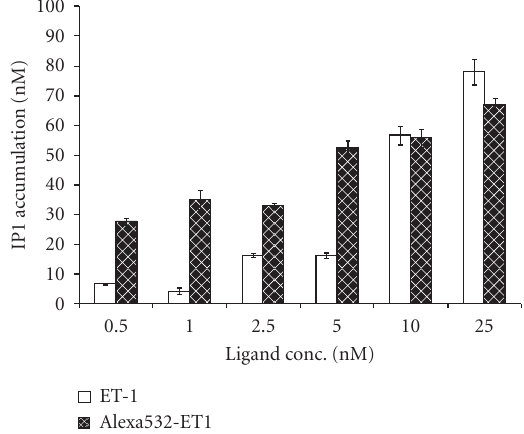
Figure 4: Results of the inositol phosphate (IP1) production assay after stimulation of A10 cells with di ff erent concentrations of nonlabeled endothelin 1 and Alexa532-ET1. Data are presented as the mean ± SEM of eight